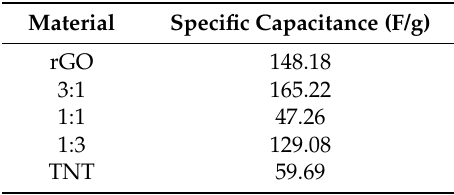
Table 3. Specific capacitance of rGO/TNT composites at 5 mV/s.